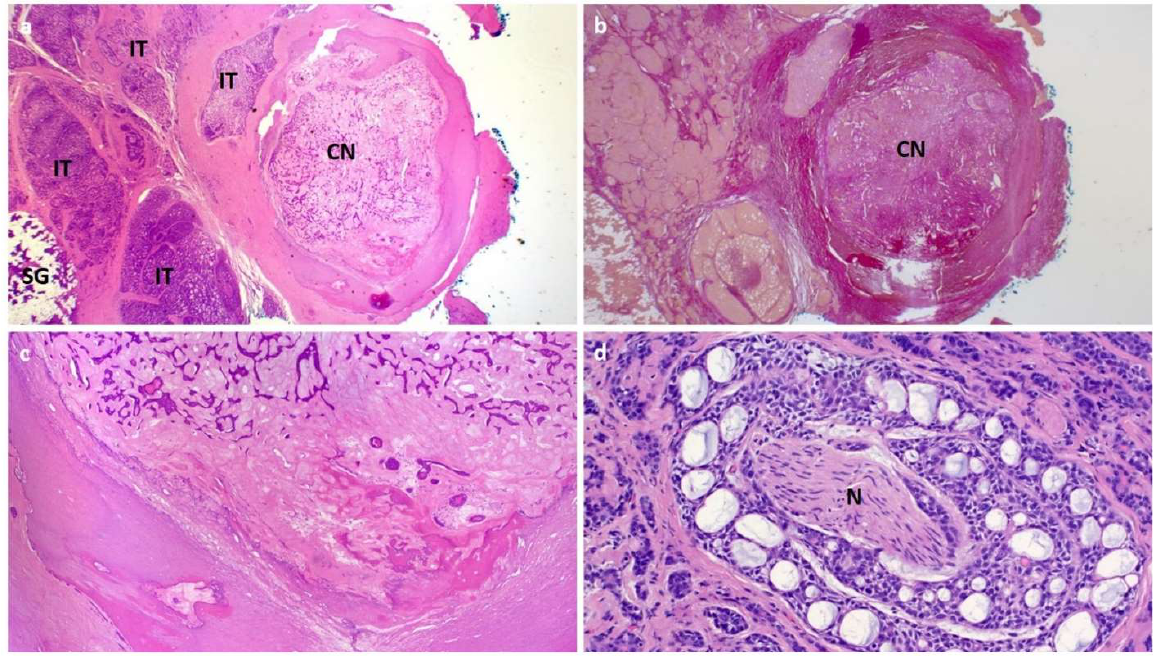
Figure 2. Histopathologic findings of the first case revealing a calcified adenoid cystic carcinoma of the left parotid gland. ( a ) Low power photomicrograph illustrating a 5 mm encapsulated and exten- sively sclerosed and calcified tumor nodule (CN) surrounded by widely invasive tumor (IT) and a rim of salivary gland tissue (SG) at the periphery. ( b ) EvG stain highlighting the sclerosed/calcified nodule. ( c ) High power showing adenoid cystic carcinoma with regressive changes within the cal- cified nodule (upper field) and adjacent calcification (lower field). ( d ) Higher magnification of the extensive perineural invasion (N = nerve) seen in the invasive tumor component. No remnants of a pleomorphic adenoma were detected.